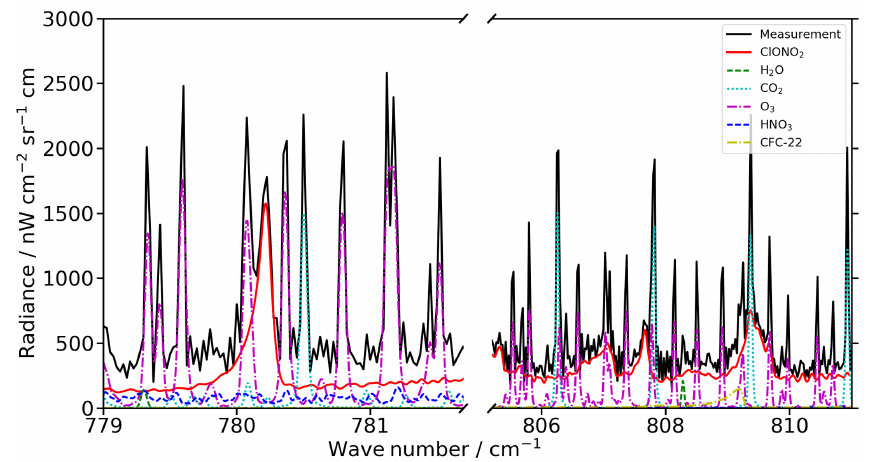
Figure 6. Example of an atmospheric limb emission infrared spectrum measured by MIPAS/Envisat (orbit 05371) on 11 March 2003 at 07:36:25UTC at a tangent altitude of 17.3km (black solid line). The contributions of single gases are calculated with the radiative transfer model KOPRA (Karlsruhe Optimized and Precis Radiative Transfer Algorithm; Stiller, 2000) and shown as colored lines (ClONO 2 is shown as red solid